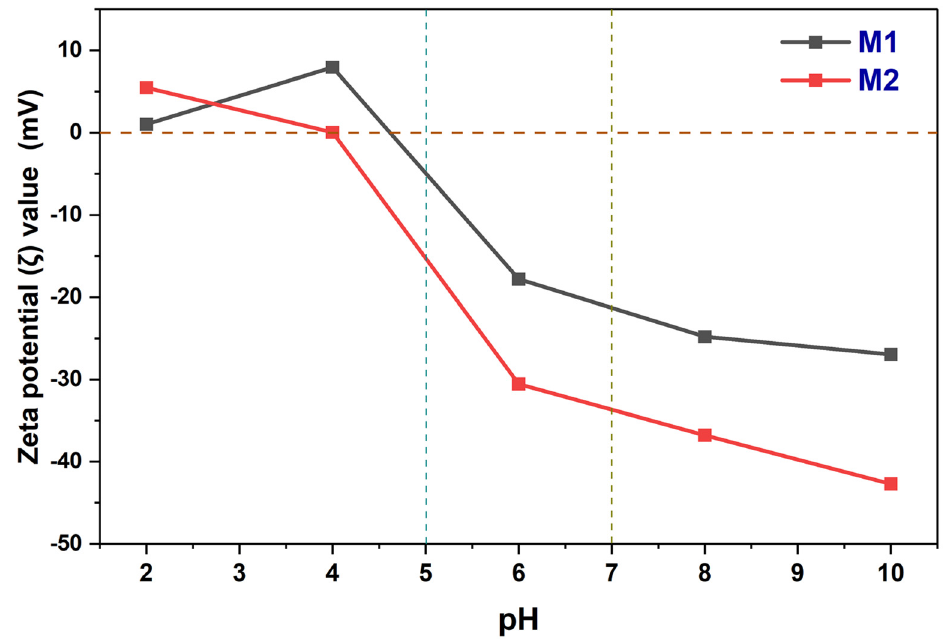
Figure 8. Zeta potential ( ζ ) observations of M1 and M2